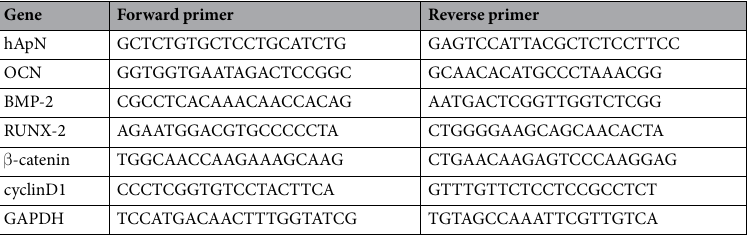
Table 2. Primers used for